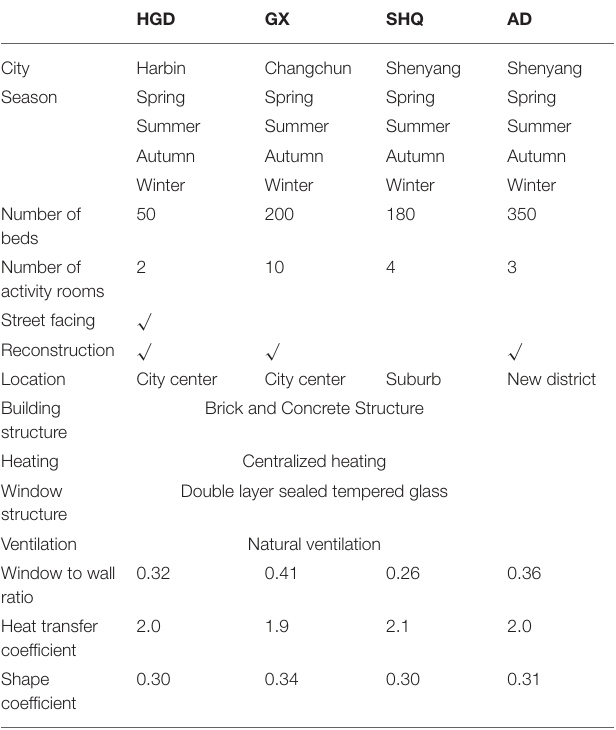
TABLE 1 | Profiles of the four facilities.